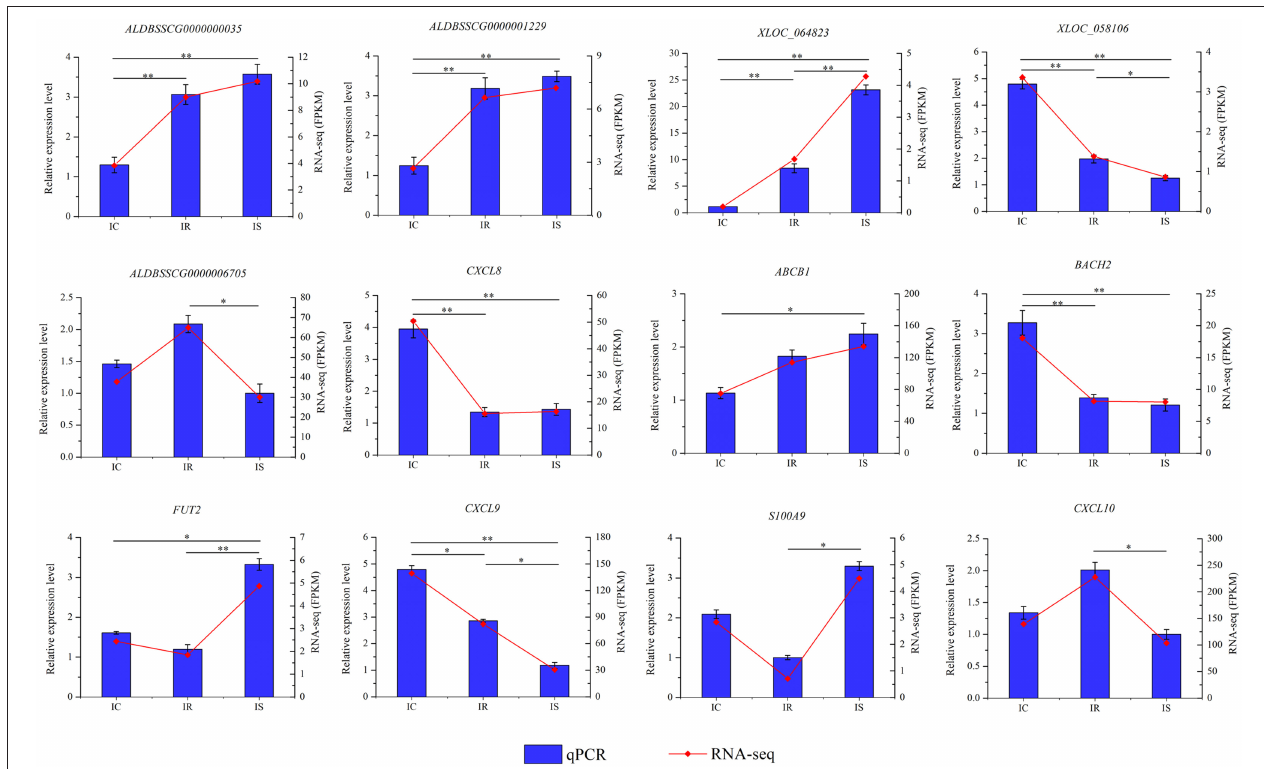
FIGURE 8 | Validation of RNA-seq results by quantitative reverse transcription polymerase chain reaction (qPCR). Porcine GAPDH gene is used as the endogenous control. Expression was quantified using the comparative cycle threshold (2 − 11 Ct ) value method. The data were expressed as the mean ± SEM). An asterisk denotes a significant difference (* P < 0.05; ** P <